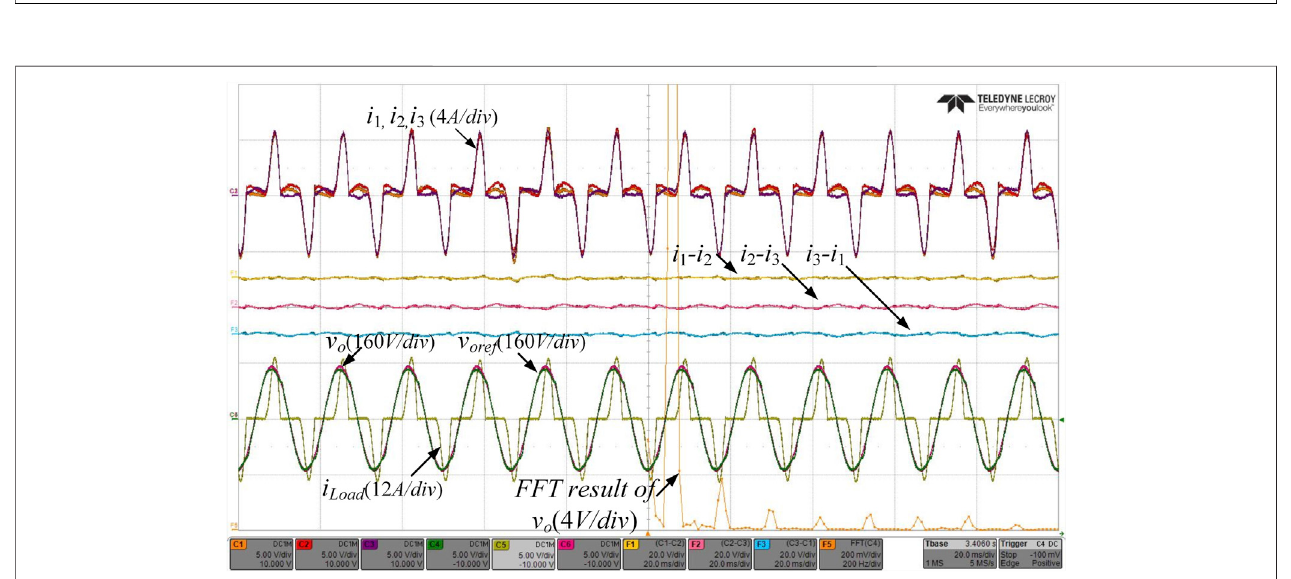
FIGURE 15 | Nonlinear load under balanced